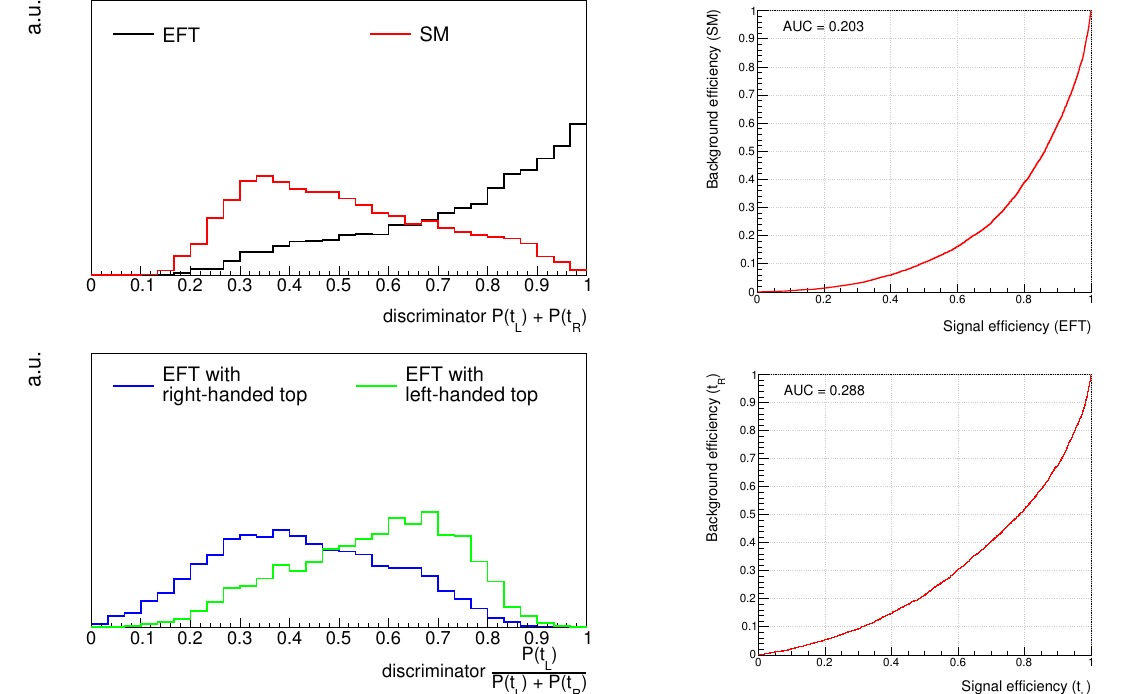
Figure 9 . Discriminator distributions of combined outputs of the neural network that discriminate the SM processes from the EFT processes (top left) and the EFT operators with a t L current form the ones with a t R current (bottom left). The ROC curves corresponding to each of these distributions are shown on the right and the area under the ROC curve (AUC) is